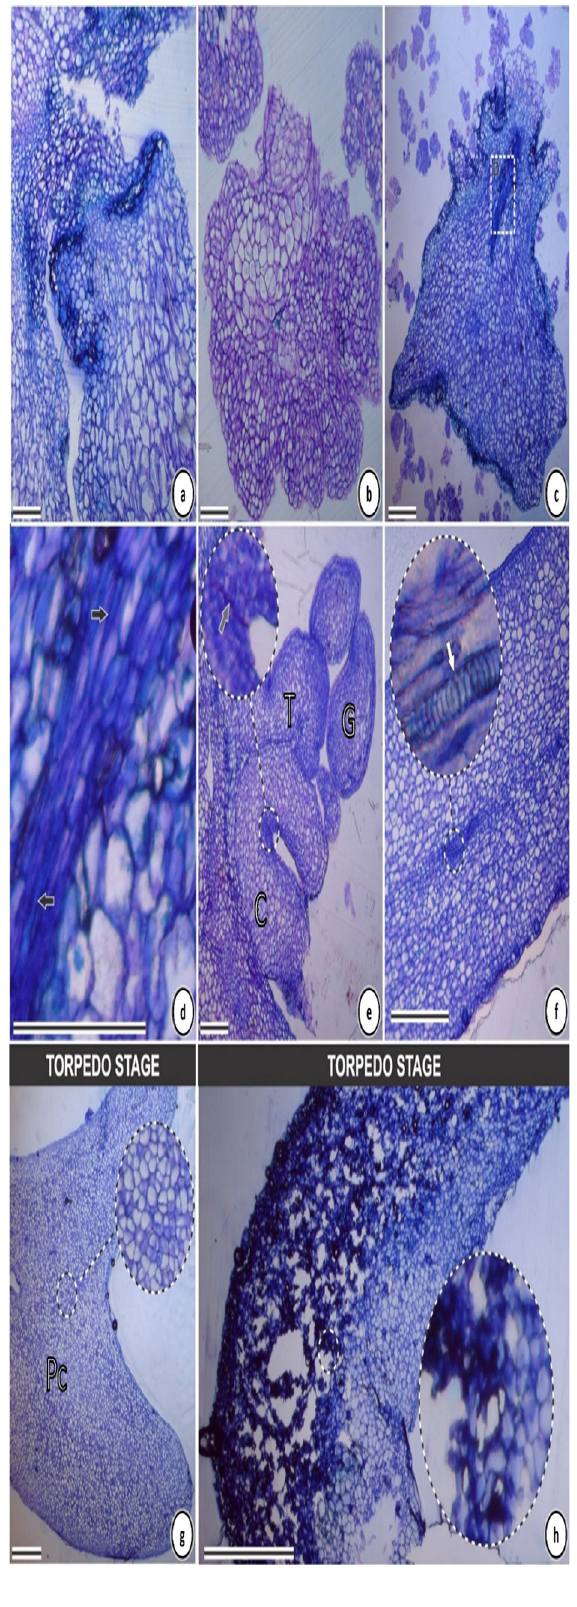
Figure 4. Histology of EMs and somatic embryos of Plinia cauliflora. (a) Formation of EMs from seeds in the medium containing 15 μM 2,4-D. (b) In the medium containing 2,4-D, without activated charcoal. (c) In the medium containing 2,4-D and activated charcoal. (d) Detail of C, arrows indicate the elongated procambial cells. (e) Somatic embryos during maturation, in several stages: G = globular, T = torpedo, C = cotyledonary. Gray arrow indicates phenolic compounds in the apical meristem. (f) Globular embryo. White arrow: xylem cell wall thickening. (g and h) Torpedo embryo during the maturation phase, Pc = procambio. Details: healing zones and cell death in the region of the vascular elements (g and h). Bars: 50